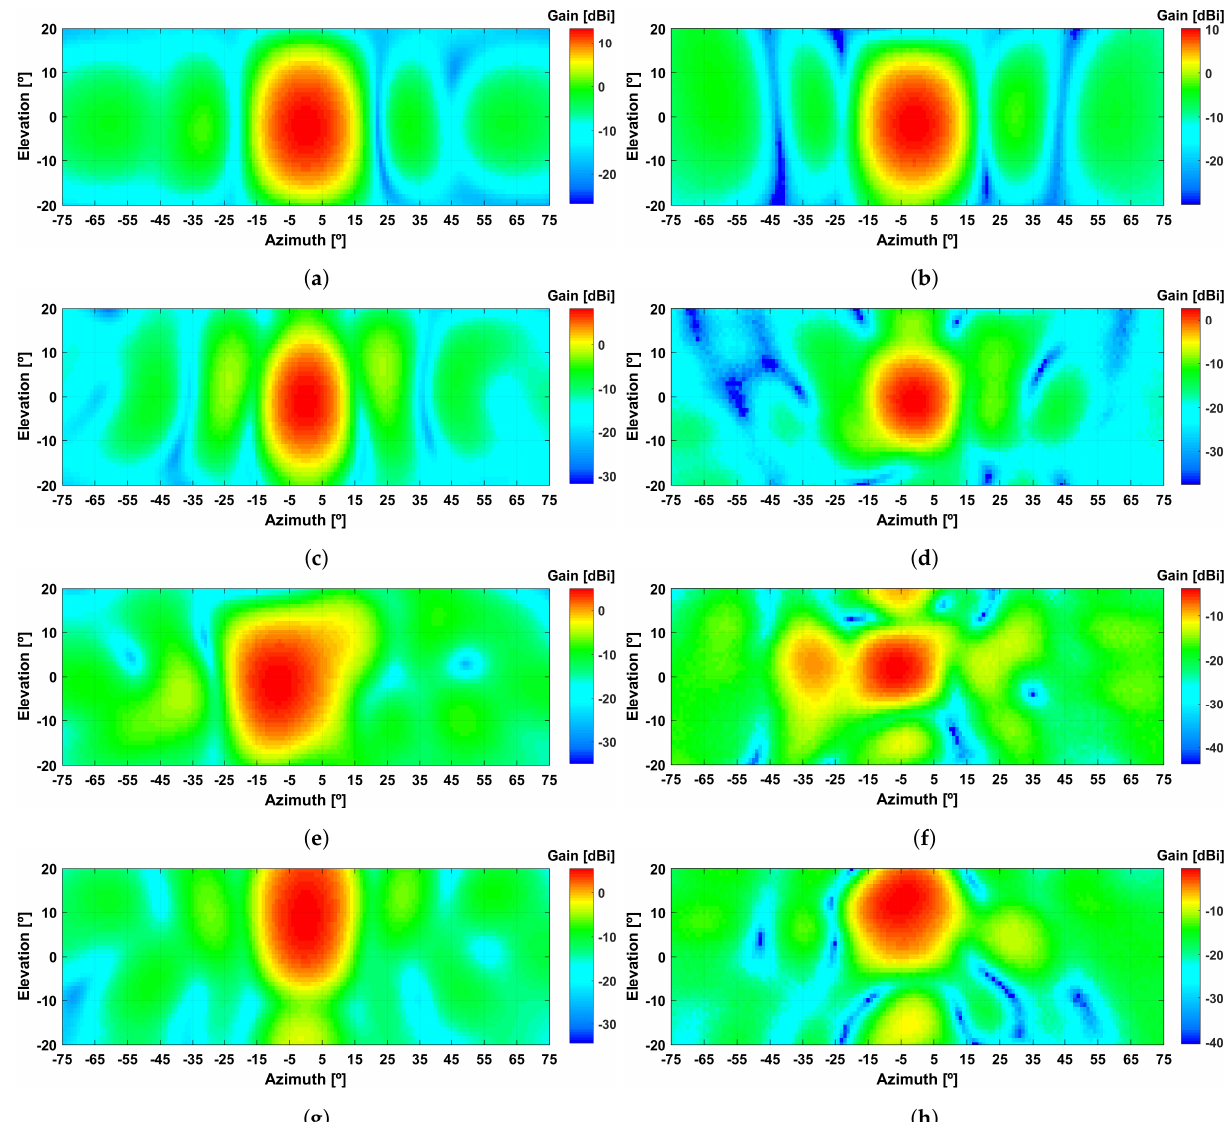
Figure 9. Simulated and measured 3D radiation patterns for: ( a , b ) microstrip array and; transmitarray set to steer towards: ( c , d ) Az = 0 ◦ and El = 0 ◦ , ( e , f ) Az = − 10 ◦ and El = 0 ◦ and ( g , h ) Az = 0 ◦ and El = 15 ◦